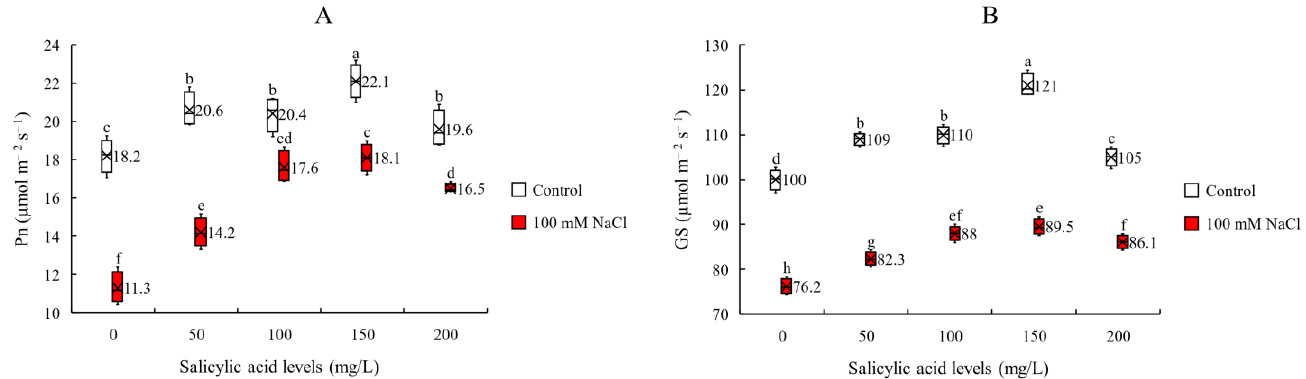
Figure 2. ( A ) photosynthetic rate (Pn) and ( B ) stomatal conductance (Gs) of sorghum plants for the interaction of SA treatments × salinity (100 mM NaCl) in four repetitions at fifty percent flowering stage. Different letters indicate significant differences by HSD at p < 0.05. The data for analysis are given in Table S1.